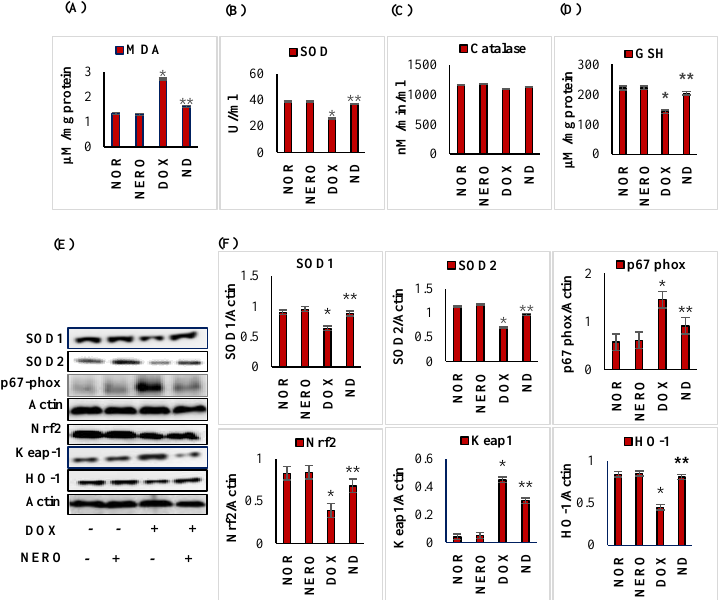
Figure 2. ( A – D ) Effect of NERO on lipid peroxidation and oxidative stress. Lipid peroxidation and antioxidant status in the heart. Each column is mean ± SEM for eight rats in each group; columns do not share a common symbol (*, **) and differ significantly with each other (* p < 0.05 vs. normal control, ** p < 0.05 vs. DOX control). (E and F). Western immunoblot analysis and densitometric analysis for SOD1, SOD2, p67-phox, Nrf2, HO-1, and Keap-1. Values are expressed as mean ± SEM ( n = 3); columns do not share a common symbol (*, **) and differ significantly with each other (* p < 0.05 vs. normal control, ** p < 0.05 vs. DOX control). MDA- malondialdehyde; SOD 1- superoxide dismutase 1; SOD 2- superoxide dismutase 2; HO-1-heme oxygenase-1; GSH-reduced glutathione; Nrf 2- Nuclear factor erythroid 2-related factor 2; NOR-normal; NERO-nerolidol; DOX- doxorubi- cin; ND- rats administered with a single intraperitoneal dose of DOX and orally treated with NERO.